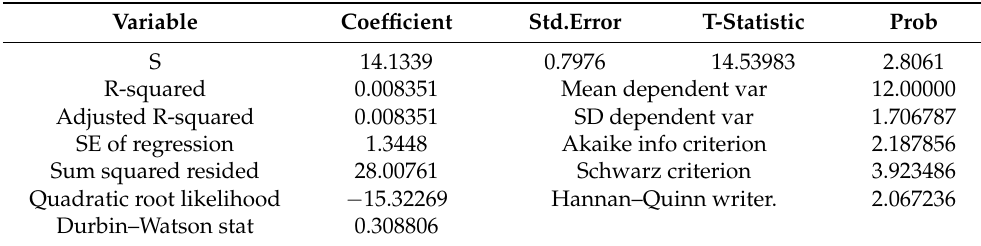
Table 7. Machine learning detection data analysis table.